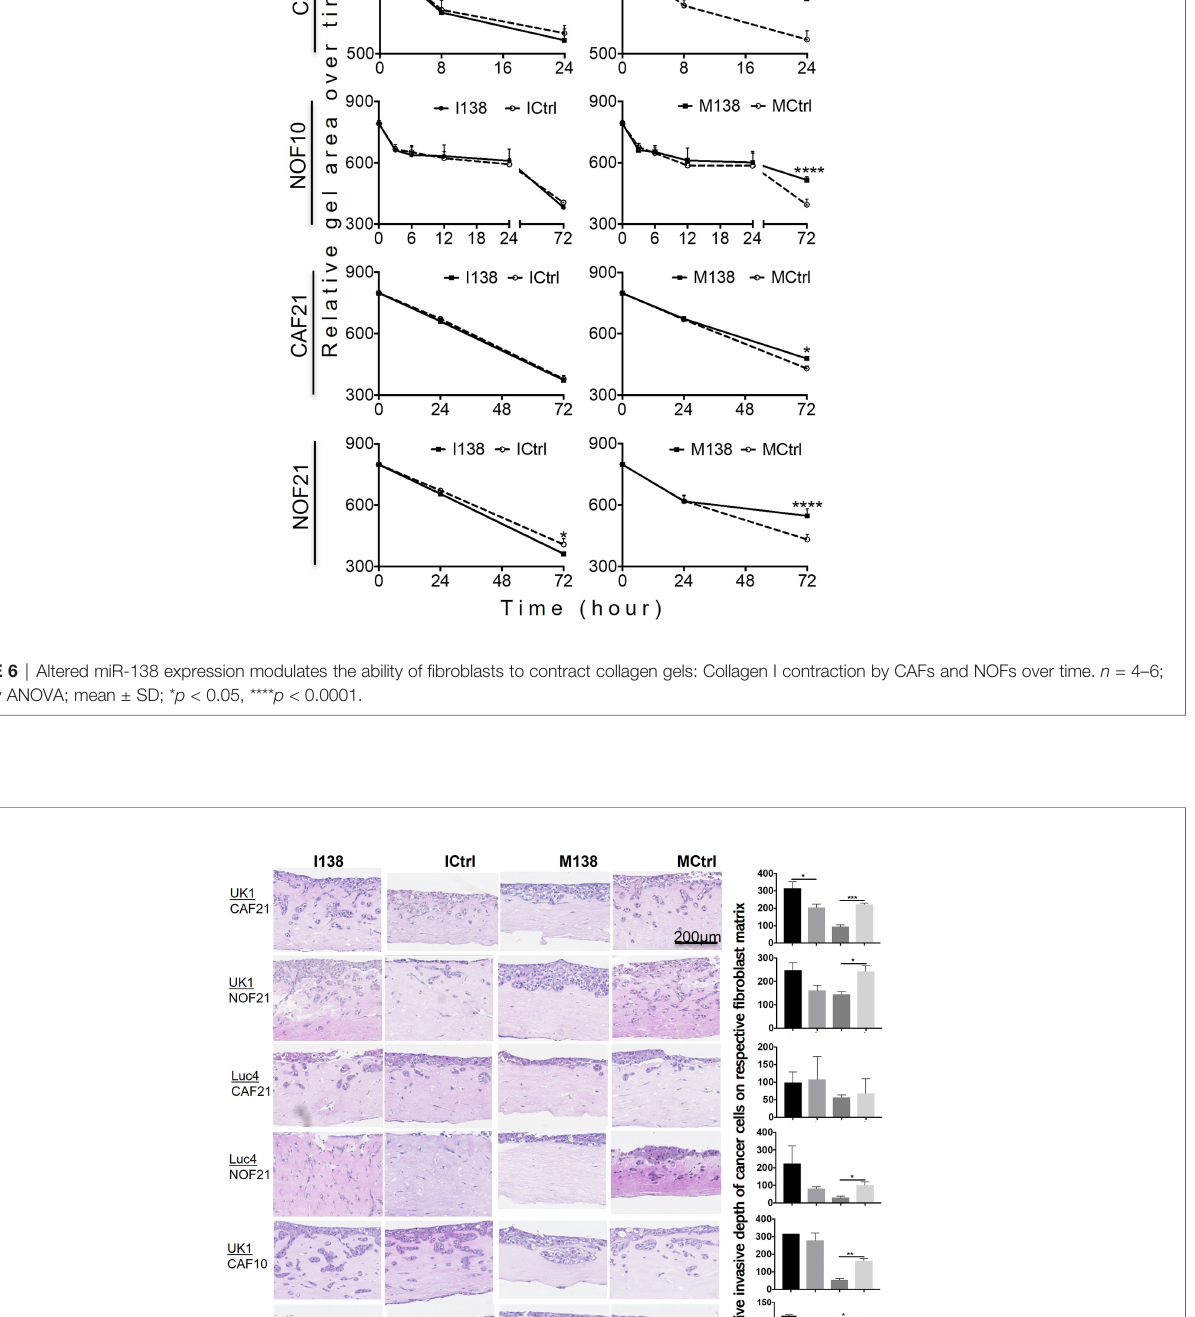
Frontiers in Oncology |